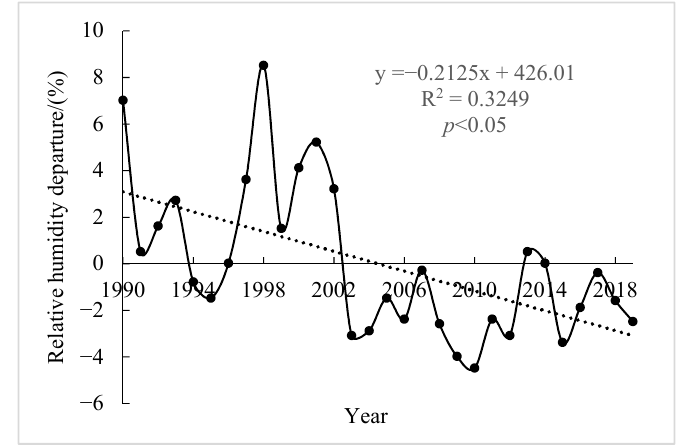
Figure 3. Variations of relative humidity departure in Beijing.